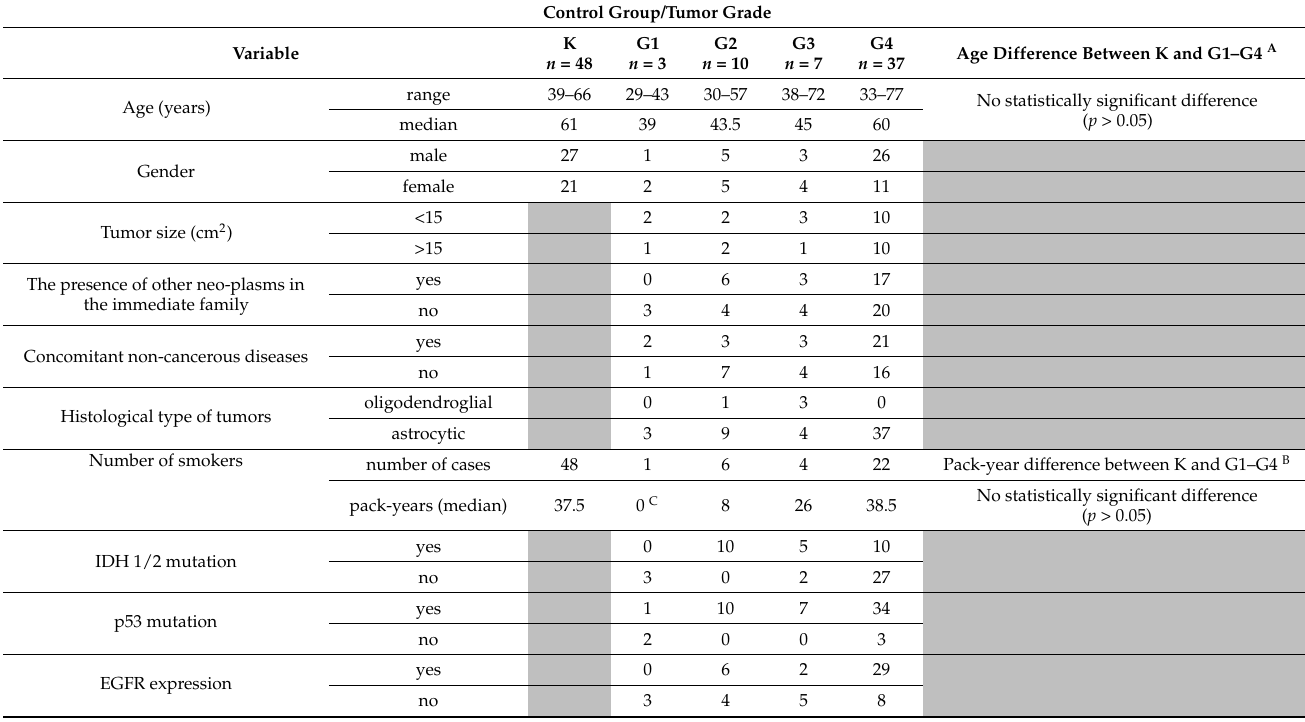
Table A1. Clinicopathological characteristics of